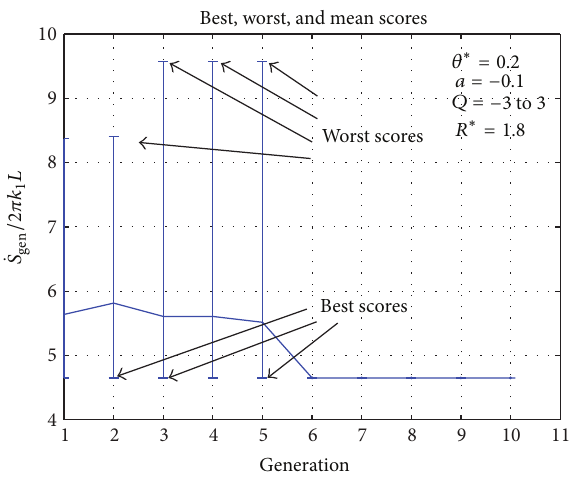
Figure 7: Variation of